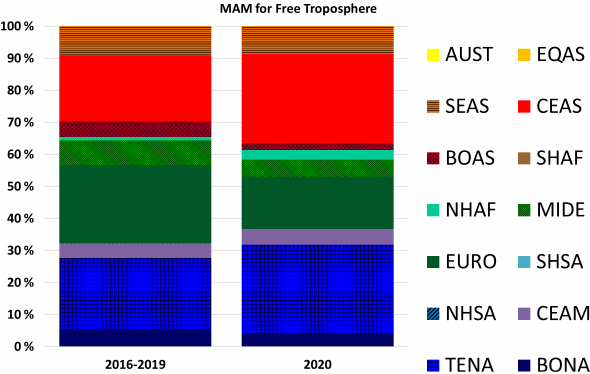
Figure 16. Contribution from different source regions to the CO in the free troposphere at Frankfurt in MAM 2020 compared with MAM 2016–2019. The colours correspond to the regions in Fig.